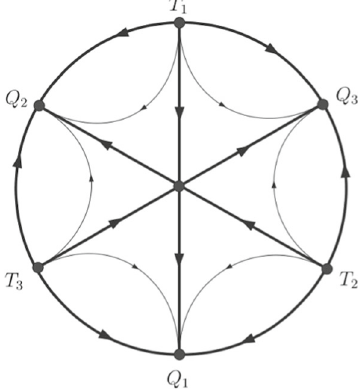
Fig. 4 The phase portrait in the Kasner disc ( (cid:2) ≤ 1) for the radiation era (w = 1 / 3). The solutions anisotropize towards the LRS models at the Q -Taub points, where (cid:2) = 1, except the FLRW universe at the origin and those at the straight segment with α = π/ 2 + 2 n π/